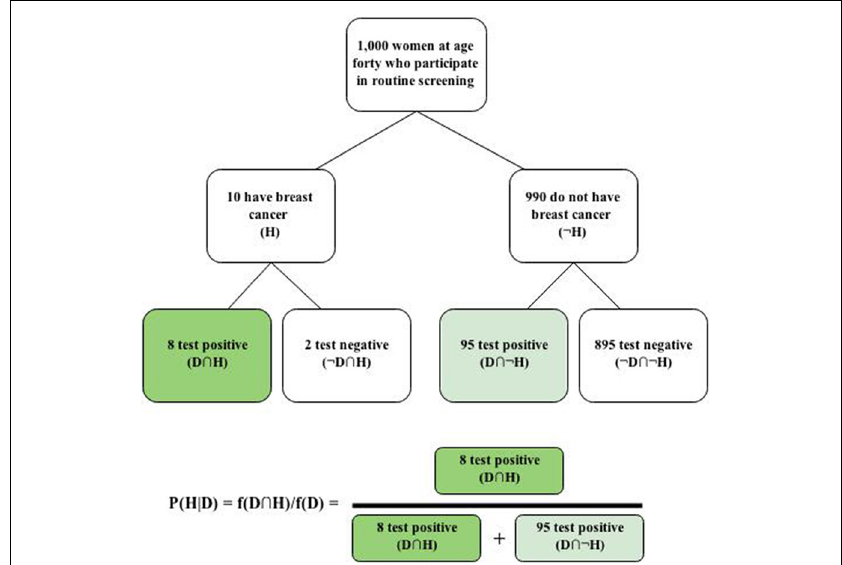
FIGURE 1 | Frequency tree and solution for the mammography